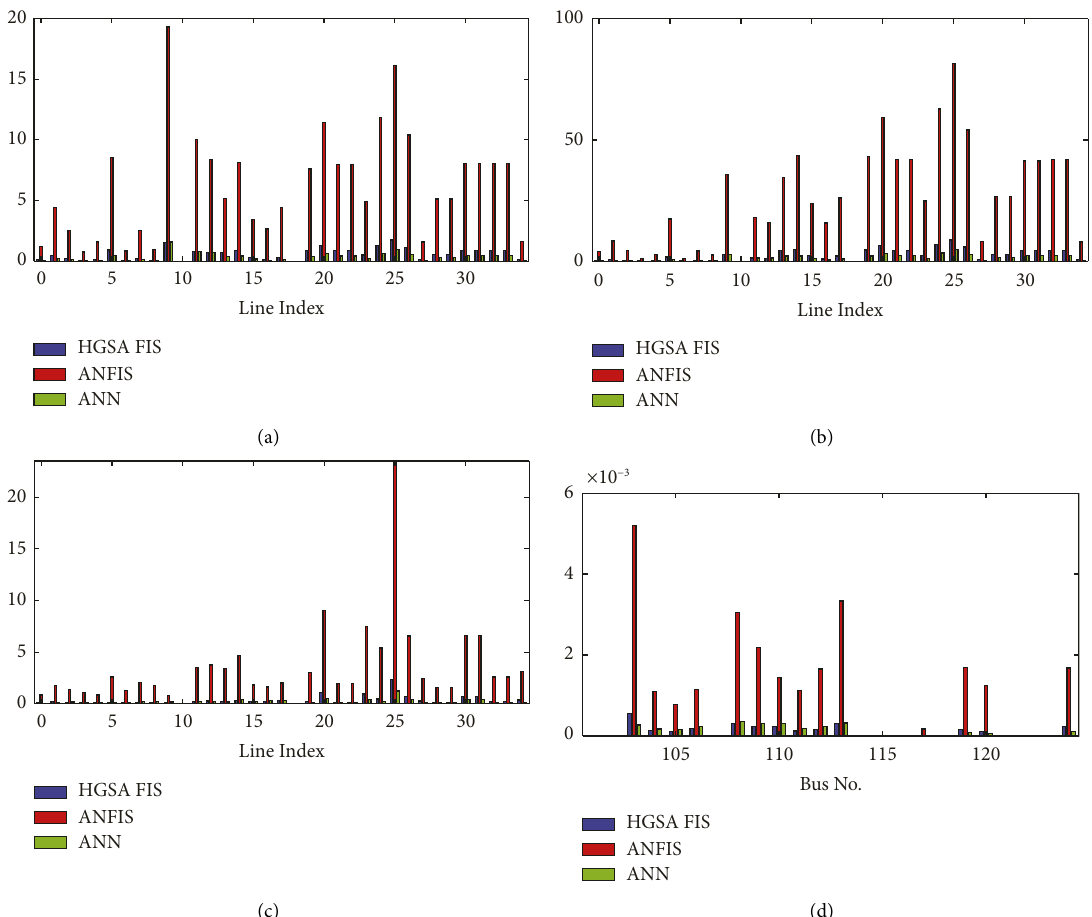
Figure 17: Maximum absolute deviations of (a) percent line loading (%), (b) lines active power flow (MW), (c) lines reactive power flow (MVAR), and (d) buses voltage